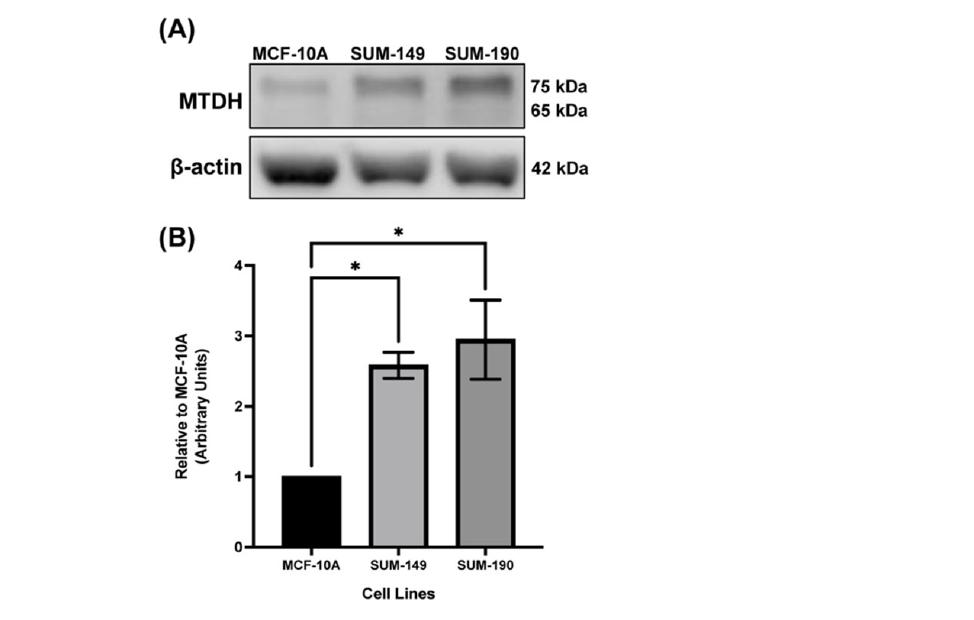
Figure 1. Basal MTDH expression in IBC cell line models and non-cancerous mammary epithelial cells. ( A ) Total protein lysates of MCF-10A, SUM-149, and SUM-190 were probed using the indicated antibodies. β -actin was used as a loading control. ( B ) Densitometry quantification of MTDH in MCF-10A, SUM-149, and SUM-190 cells. Data are expressed relative to MCF-10A cells. Ordinary one-way ANOVA with Bonferroni’s multiple comparison test, * p < 0.05. Results are shown as Mean ± SEM.